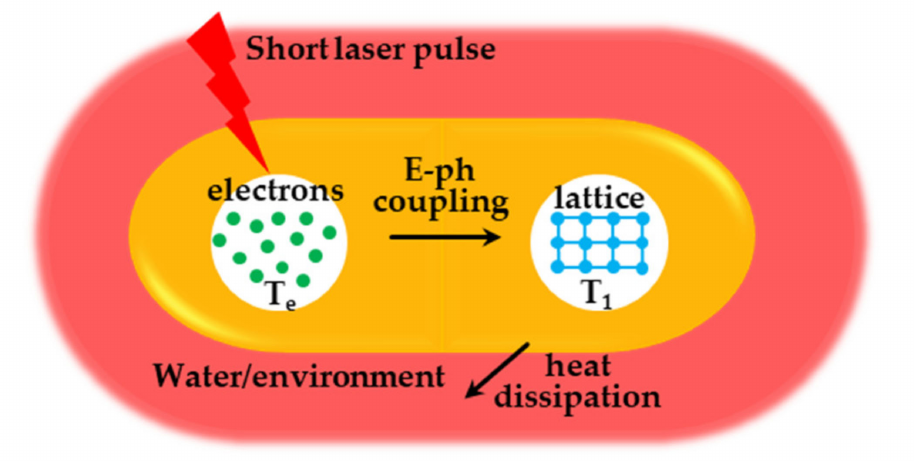
Figure 13. The physical process of photothermal conversion of gold nanorods activated by femtosec- ond laser